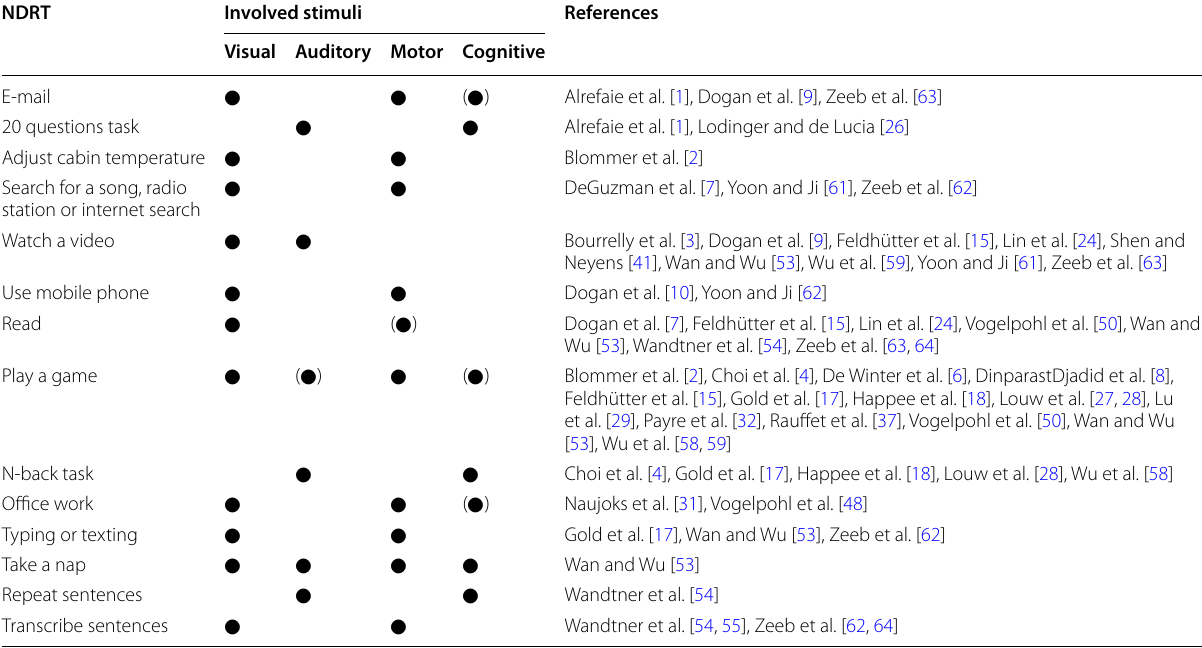
Table 1 NDRTs identified in the selected studies NDRT Involved